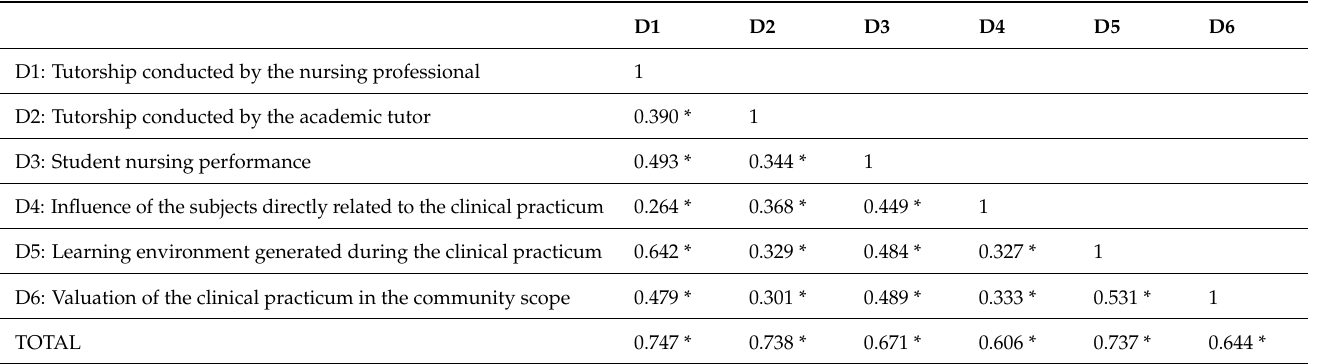
Table 5. Correlations of the Questionnaire of Perception toward the Clinical Learning Process (QPCLP) and total questionnaire (rho). D1 D2